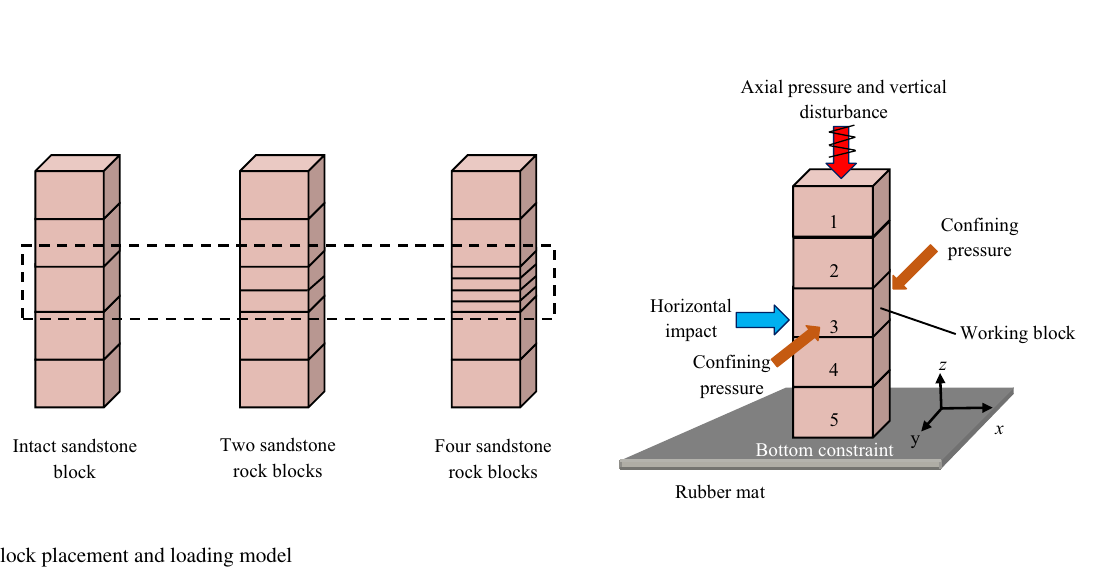
Fig. 6 Block placement and loading model